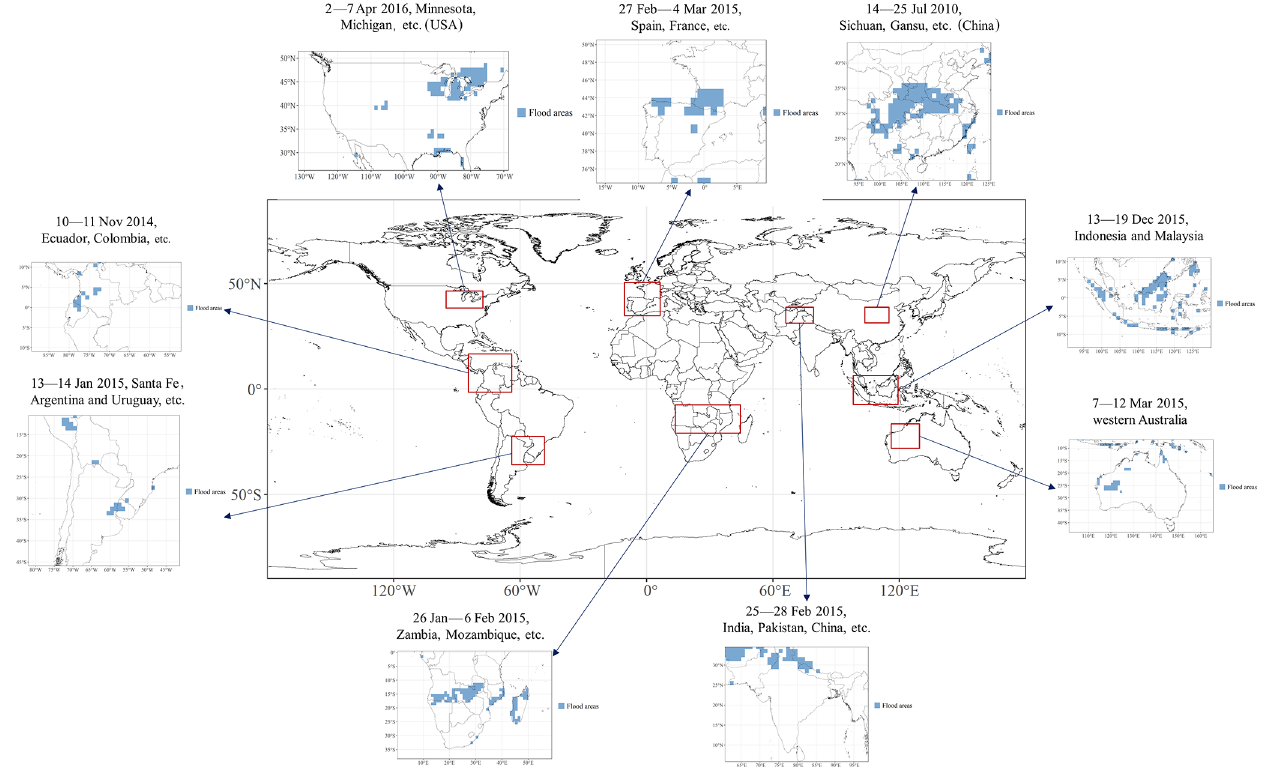
Figure 11. Validation of some flood events recorded by social media and news but not by the DFO.